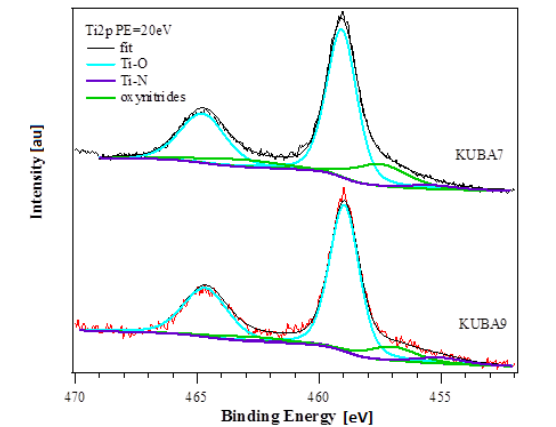
Figure 11. XPS spectrum close to Ti 2p line for K7 and K9 samples.